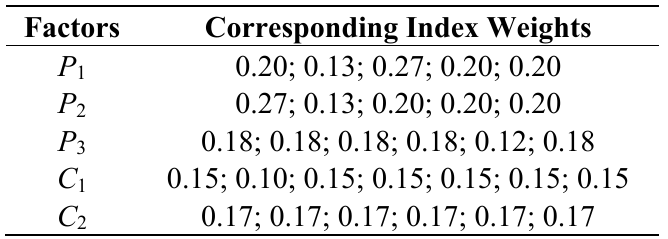
Table 2. The weights of